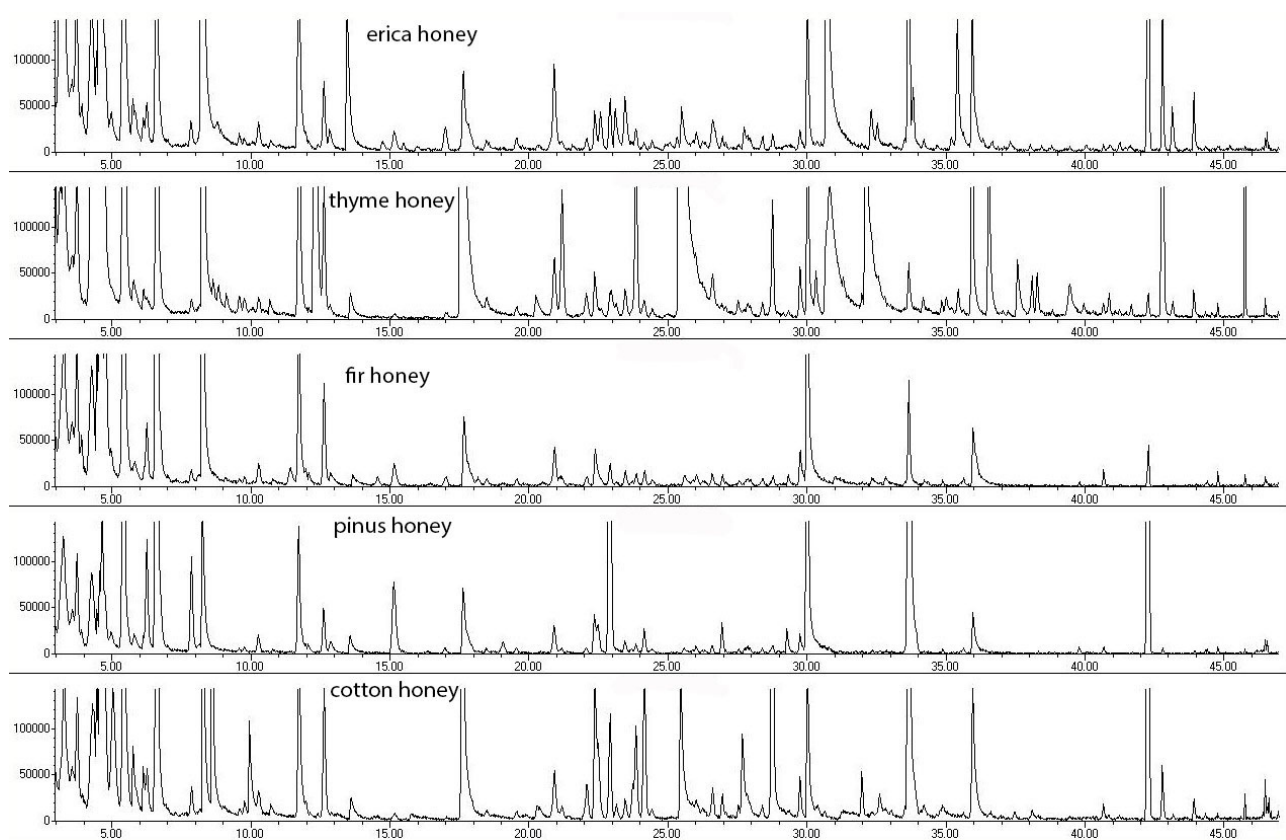
Figure 2. Representative chromatogram for each studied monofloral honey type.